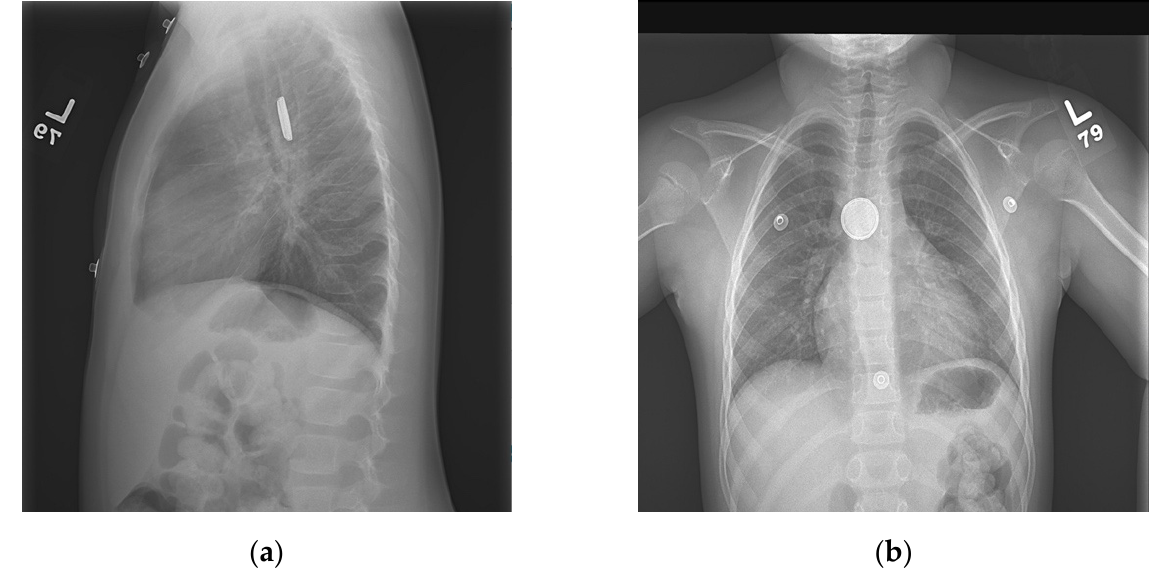
Figure 1. ( a ) Lateral chest X-ray showing the button battery with a step-off appearance in the mid-esophagus; ( b ) AP chest X-ray showing the button battery with a double halo/ring sign in the mid-esophagus. We performed an esophogastroduodenoscopy (EGD) 6 h after ingestion and discov- ered a 20 mm BB in the middle third of the esophagus (Figure 2). We successfully removed the BB with rat tooth forceps without complications. Visualization of the site showed mucosal ulceration and erosion (Figure 3). According to the commonly used Zargar clas- sification of esophageal injuries, this lesion was determined to be Grade 2B due to the erosion’s circumferential nature. The endoscope was advanced to the stomach and showed no damage. A nasogastric (NG) tube was not placed at the time of the endoscopy.